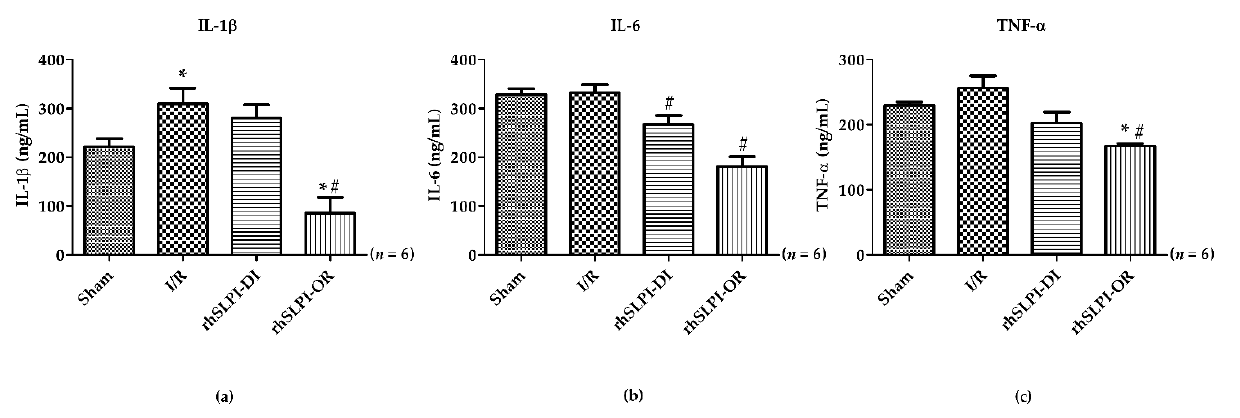
Figure 4. Determination of effect of post-ischaemic treatment of rhSLPI on cardiac inflammatory cytokines level including IL-1 β ( a ), IL-6 ( b ) and TNF- α ( c ) in the sham group, I/R group, rhSLPI-DI and rhSLPI-OR (* p < 0.05 vs. sham) ( # p < 0.05 vs. I/R) ( n = 6).